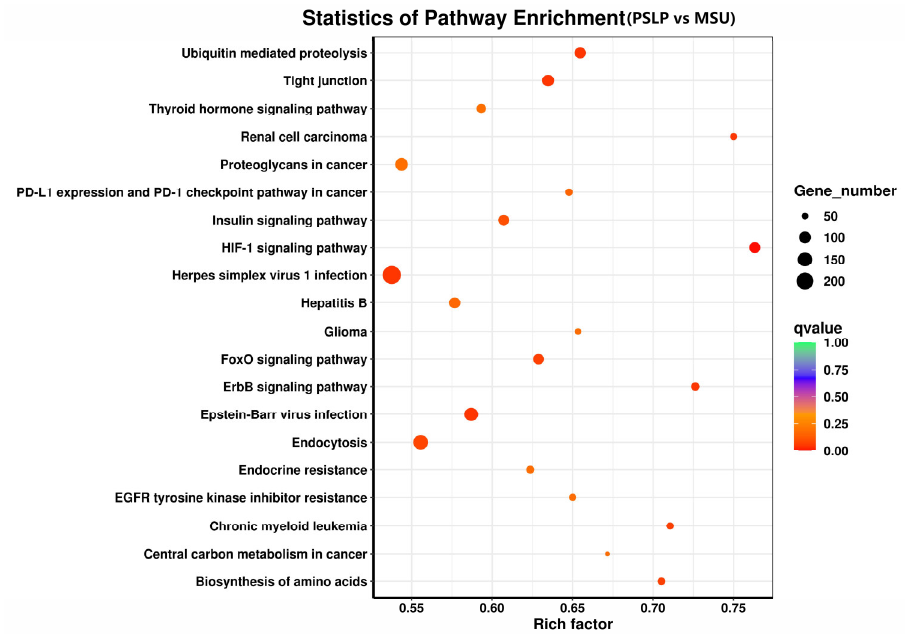
Figure 9. The KEGG pathway enrichment analysis of DEGs. KEGG pathway analysis of DEGs comparing the PSLP group and the MSU group. The dot size indicates the amount of DEG enriched in the pathway. The darker the color, the more significant the enrichment result.